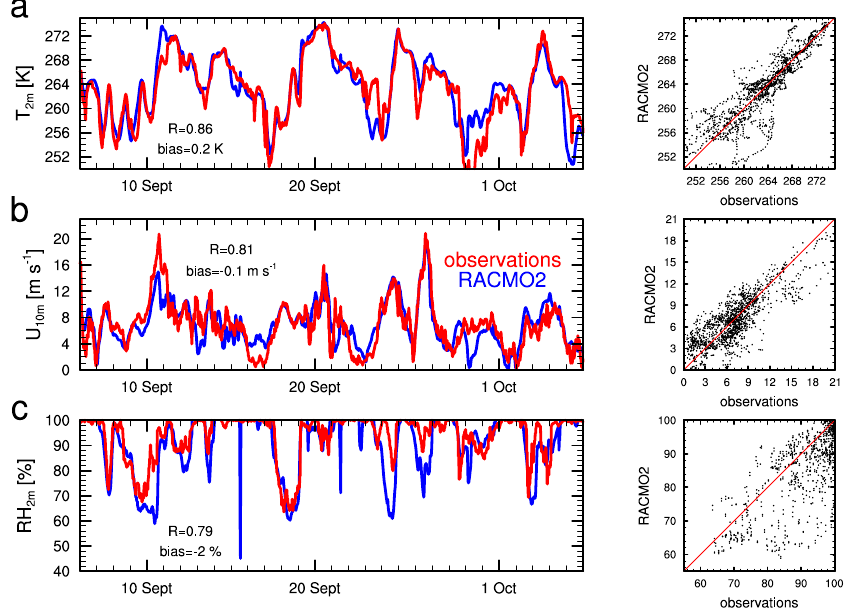
Fig. 4. Time evolution of (a) 2m temperature, (b) 10m wind speed and (c) relative humidity according to the observations (red lines) and RACMO2 (blue lines). The panels on the right show the correlations between observations and RACMO2, with the 1 : 1 line in red. The correlation coefficient ( R ) and mean bias are shown in the left